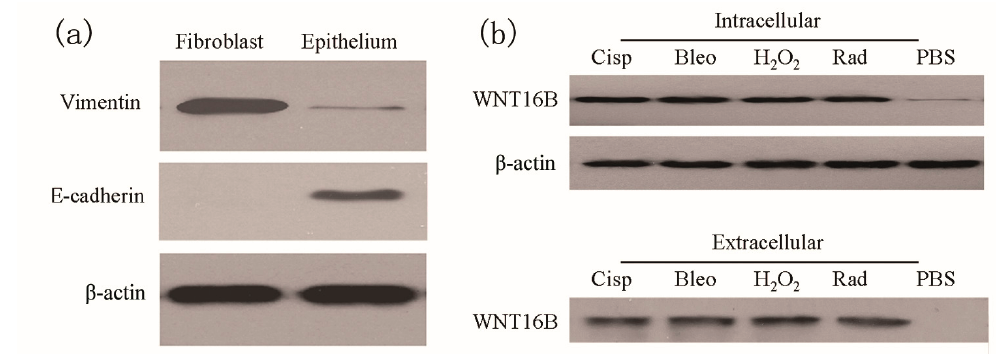
Figure 1. DNA damage-associated treatment to primary ovarian fibroblasts induced expression and secretion of WNT16B. ( a ) Biomarker identification of primary ovarian fibroblasts by Western blot. Fibroblast presented higher level of Vimentin; however, epithelium presented higher level of E-cadherin; ( b ) WNT16B expression and secretion of ovarian fibroblast was induced following DNA damage-associated treatment. Western blot showed that obvious elevation of WNT16B in intracellular space after treatment including cisplatin (Cisp), bleomycin (Bleo), H O and radiation (Rad). Western blot also showed 2 2 WNT16B was secreted into the extracellular space after the same treatment (equal volume per well). PBS (phosphate buffered saline) was used as